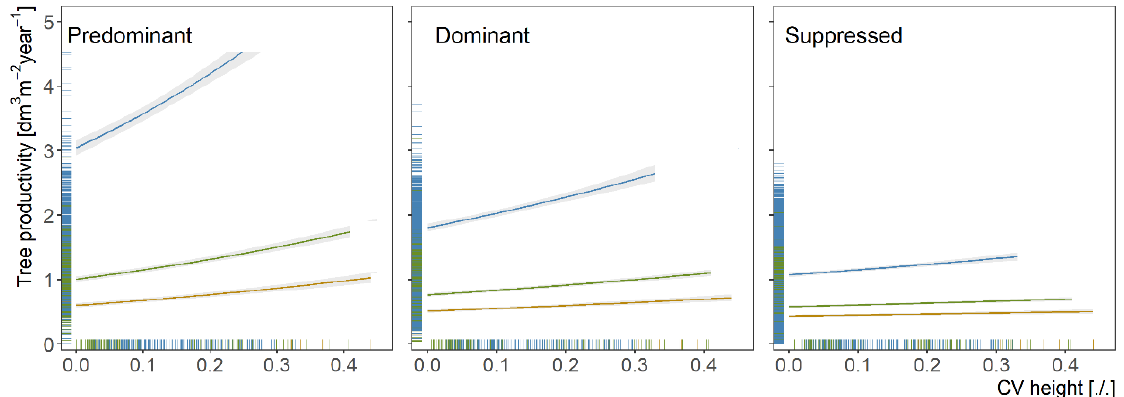
Figure 5. Productivity of oak trees as a function of coefficient of variation of tree heights and age for predominant ( rel_d > 0.9), dominant ( rel_d < 0.9 and >0.7) and suppressed ( rel_d < 0.7) oaks in monospecific stands; rugs on the x-and y-axis indicate the observed values of cvh and tree productivity, respectively; all other variables were set to their mean.